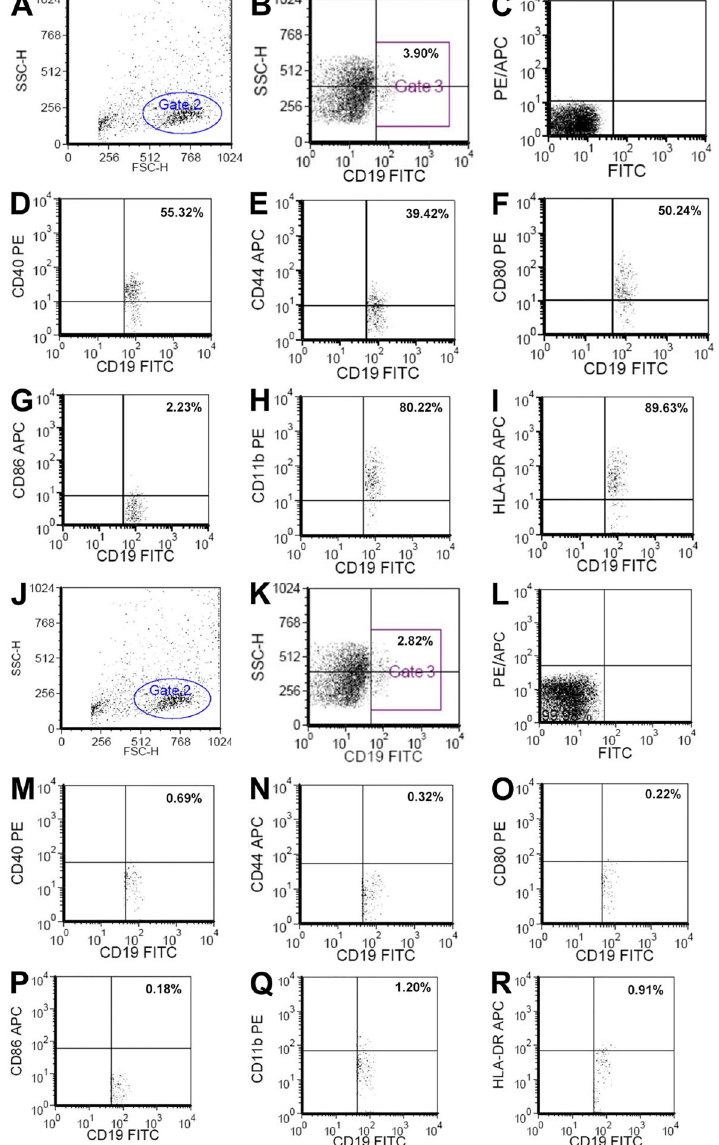
Figure 2. Representative images showing the proportion of B cell surface activation markers in peripheral blood mononuclear cells (PBMCs) from one patient with psoriasis vulgaris at the active stage ( A – I ) and one healthy control ( J – R ) deter- mined by fl ow cytometry. A , total lymphocytes from PBMCs (Gate 2). B , proportion of CD19 + B cells from PBMCs (Gate 3). C , negative control (FITC and PE/APC). Proportion of CD19 + CD40 + ( D ), CD19 + CD44 + ( E ), CD19 + CD80 + ( F ), CD19 + CD86 + ( G ), CD19 + CD11b + ( H ), and CD19 + HLA-DR + ( I ) B cells from PBMCs. J , total lympho- cytes from PBMCs (Gate 2). K , proportion of CD19 + B cells from PBMCs (Gate 3). L , negative control (FITC and PE/APC). Proportion of CD19 + CD40 + ( M ), CD19 + CD44 + ( N ), CD19 + CD80 + ( O ), CD19 + CD86 + ( P ), CD19 + CD11b + ( Q ), and CD19 + HLA- DR + ( R ) B cells from